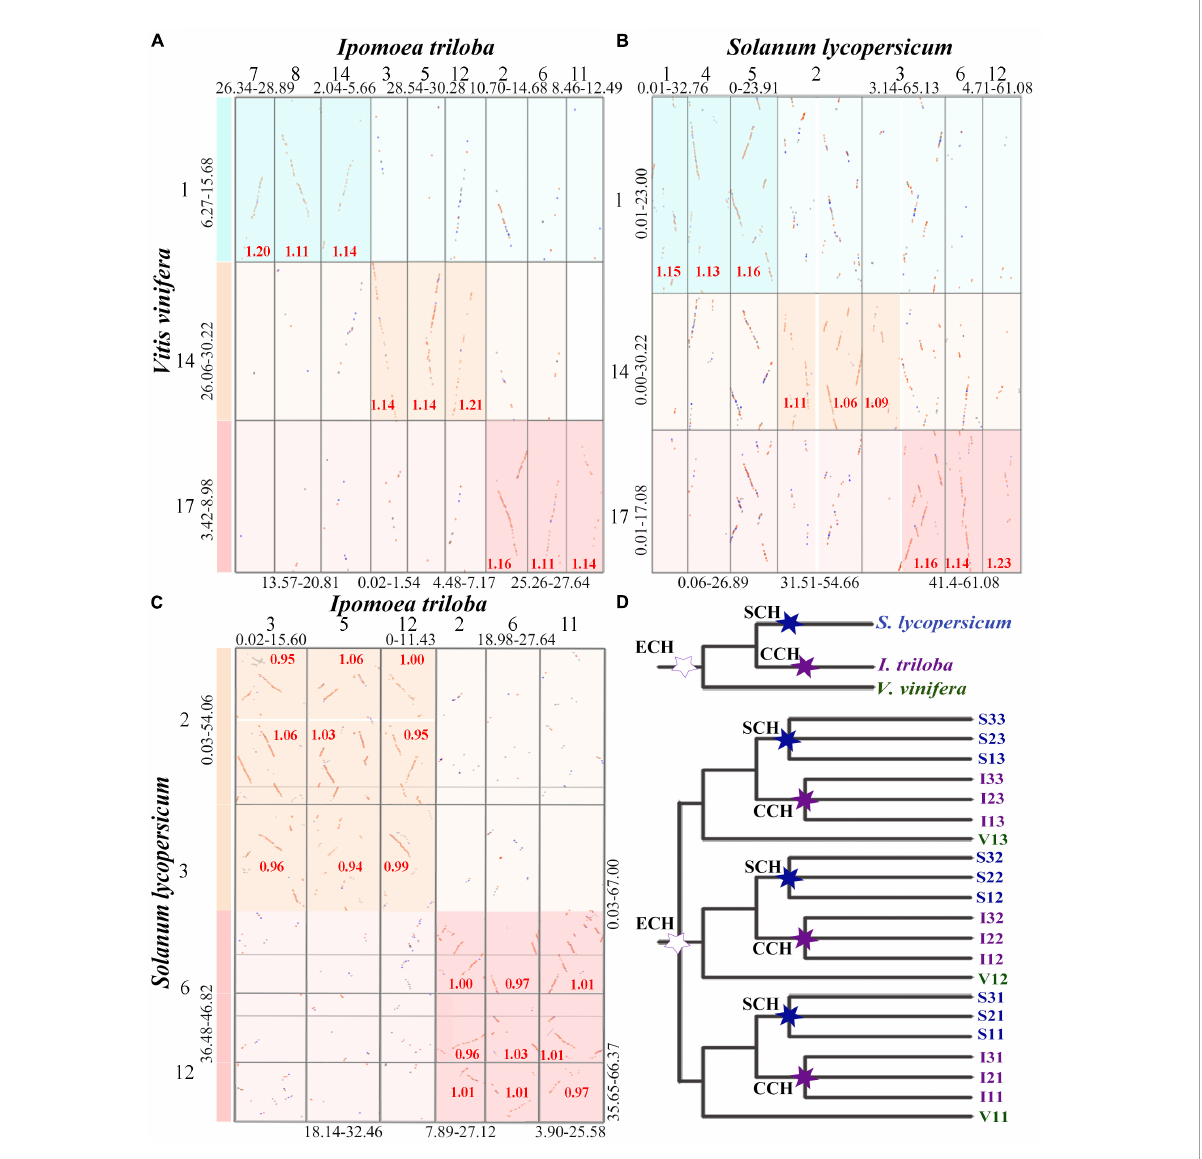
FIGURE2 Inference of the polyploidization events for Solanum lycopersicum and Ipomoea triloba . In genomic synteny local dotplots, the dark highlight boxes indicate orthologous genomic regions identified between compared genomes, and the light boxes indicate identified outparalogous genomic regions. The Ks median of gene pairs in homologous chromosomal regions is marked in the boxes. The lengths of compared chromosomes from each genome are shown in Mb. The en dash “-” indicates a range. (A) Local synteny block dotplot between the genomes of V. vinifera and I. triloba ; (B) local synteny block dotplot between the genomes of Vitis vinifera and I. triloba ; (C) local synteny block dotplot between the genomes of S. lycopersicum and I. triloba ; (D) species and inferred homologous gene tree of V. vinifera (Vvi), I. triloba (Itr), and S. lycopersicum (Sly). The hexagonal star labels on the trees indicate the inferred polyploidizations among three considered species, in which the Solanaceae common hexaploidization (SCH) is color-coded blue, the Convolvulaceae common hexaploidization (CCH) is color-coded purple, and the core eudicot common hexaploidization (ECH) is color-coded dark green.